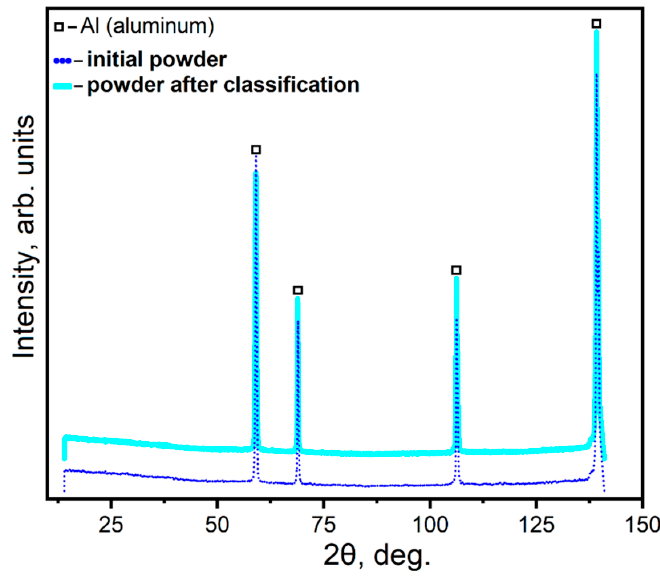
Figure 7. XRD results of ASP-30 powder before and after electrostatic classification.